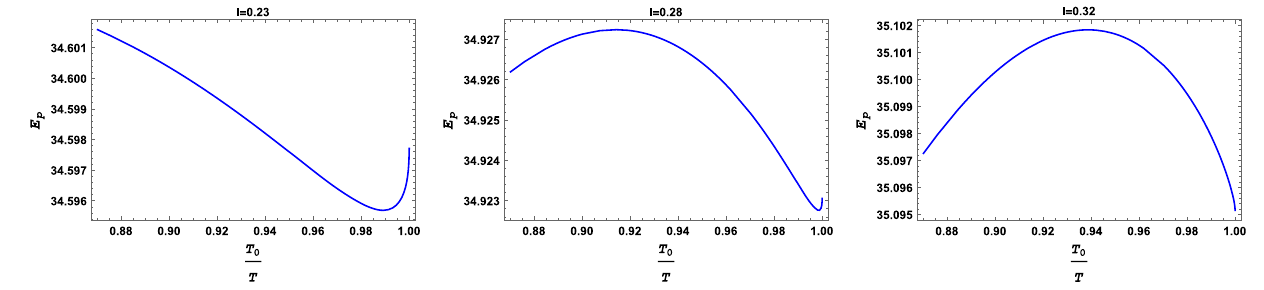
Fig. 11 The EoP as a function of T 0